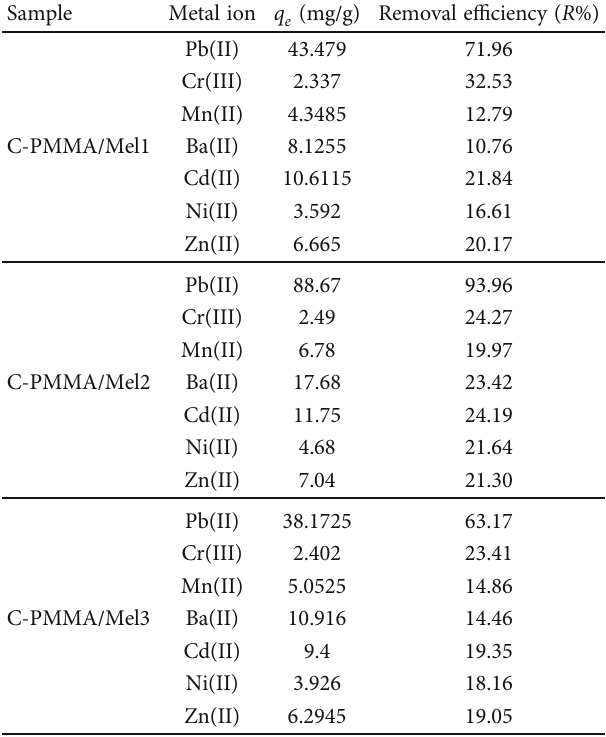
– 3) Table 3: Adsorption capacities q e (mg/g) of C-PMMA/Mel(1 and removal e ffi ciency ( R% ) toward di ff erent metal ions at initial pH = 6 and adsorbent dose of